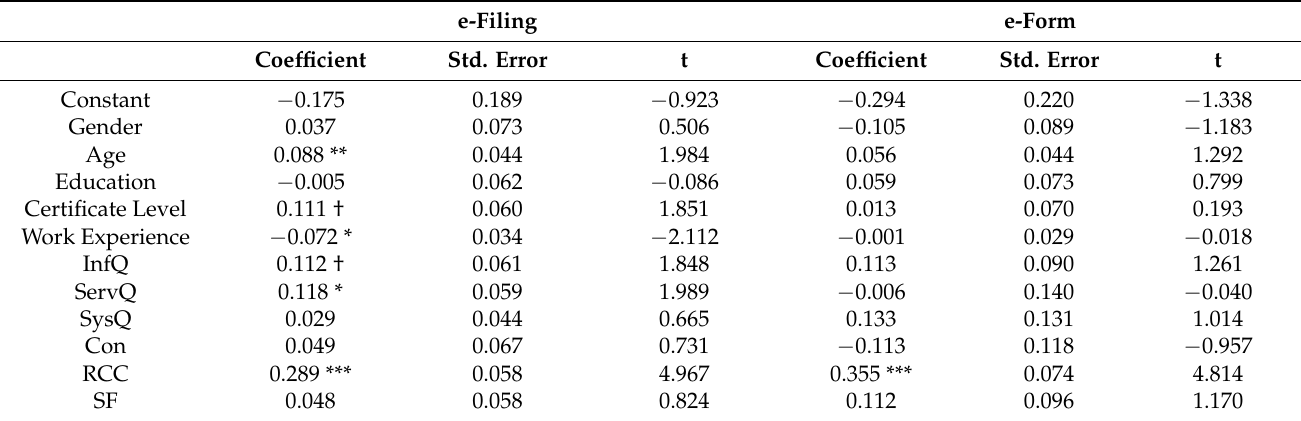
Table 6. Comparative multiple regression analysis between e-Filing and e-Form